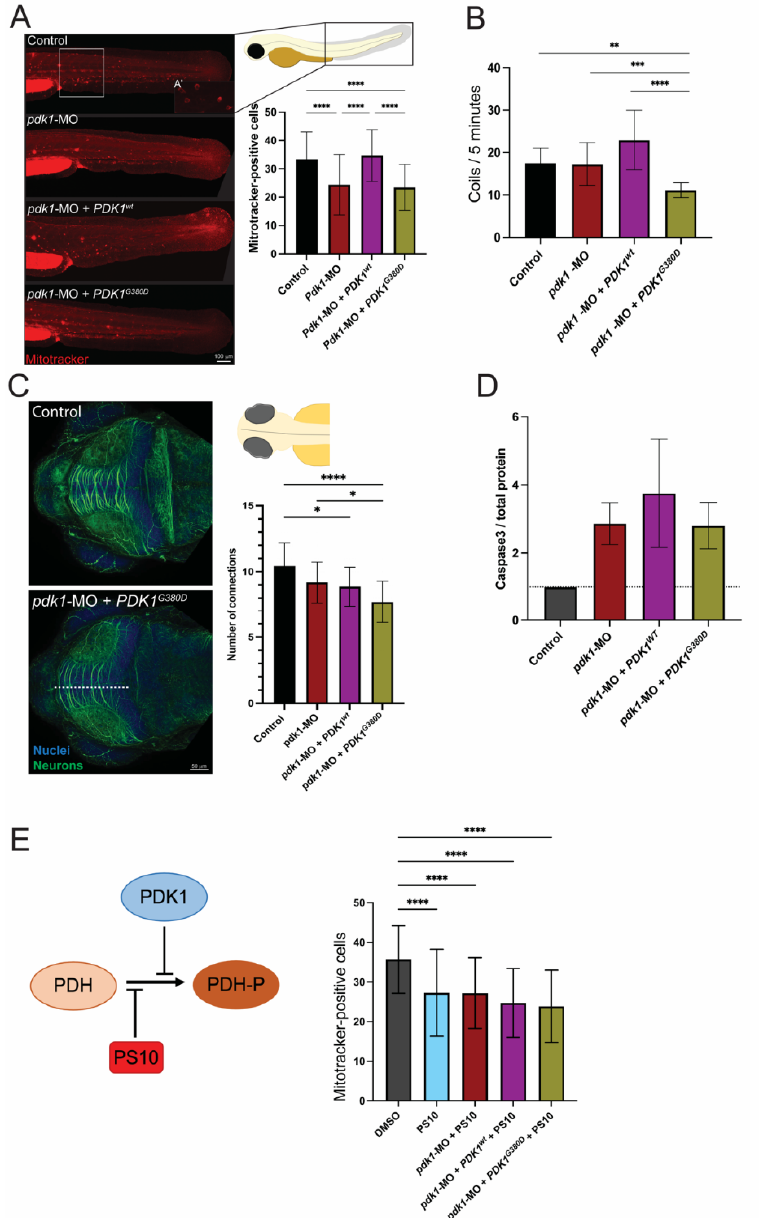
Figure 3. Expression of PDK1 G380D in zebrafish embryos affects embryogenesis. ( A ) Mitochondria with membrane potential were labeled using a Mitotracker labeling assay and the quantification was performed by counting the positively stained cells (see inset for close up on positive cells) in an area of 300 × 350 μ m in the trunk of the embryo (white box). (A’) Mitotracker-positive cells shown in higher magnification. A significant decrease in the number of cells with labeled mitochondria was found in pdk1 -MO + PDK1 G380D when compared to control and pdk1 -MO + PDK1 wt embryos (n = 40–45 per group, **** p < 0.0001). ( B ) Expression of mutant PDK1 in zebrafish embryos resulted in a significant decrease in spontaneous movements (coils) when compared to the others experimental groups (n = 108–120 embryos per group, ** p = 0.003, *** p = 0.004, **** p < 0.0001). ( C ) Neuronal differentiation was assessed by labelling embryos with acetylated-a-tubulin (neurons, in green) followed by quantification of the neuronal projections in the tectum (top view). We found a significant decrease in the number of projections crossing the white dotted line of embryos injected with pdk1 -